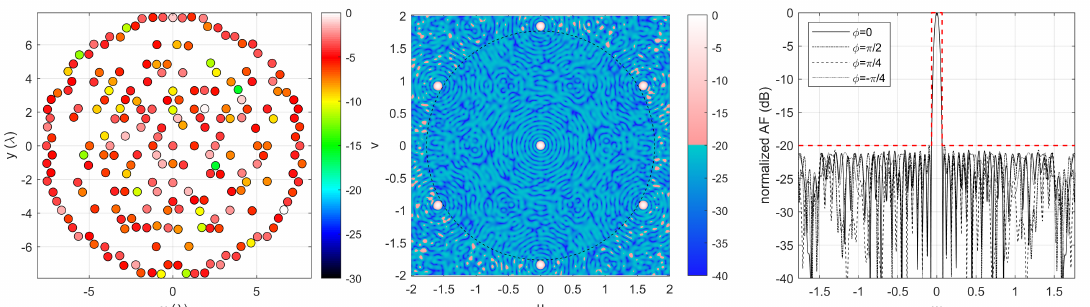
Figure 5. The 213 elements sparse layout. Left subplot: position and normalized excitation amplitude (dB) of the synthesized layout; center subplot: normalized Array Factor in the uv plane; right subplot: some relevant cuts. Negative values of w are related to the cuts φ (cid:48) = φ + π